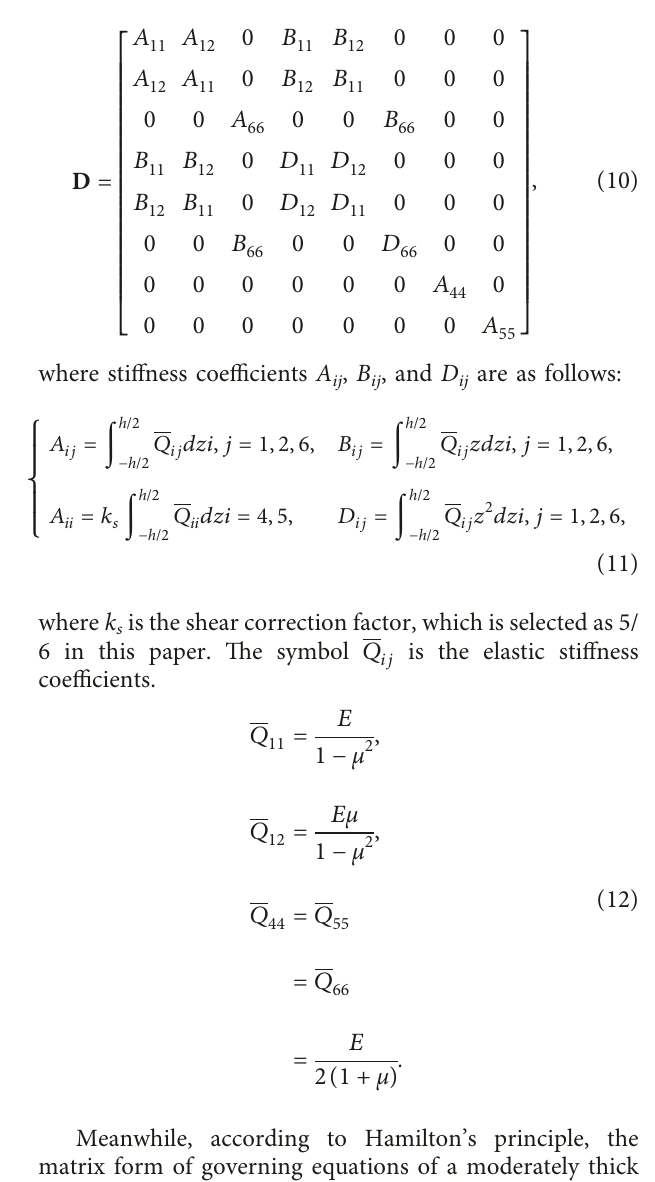
Figure 1: The geometry of bulkhead-stiffened functionally graded open conical shell (a) axial bulkhead (b) circumferential